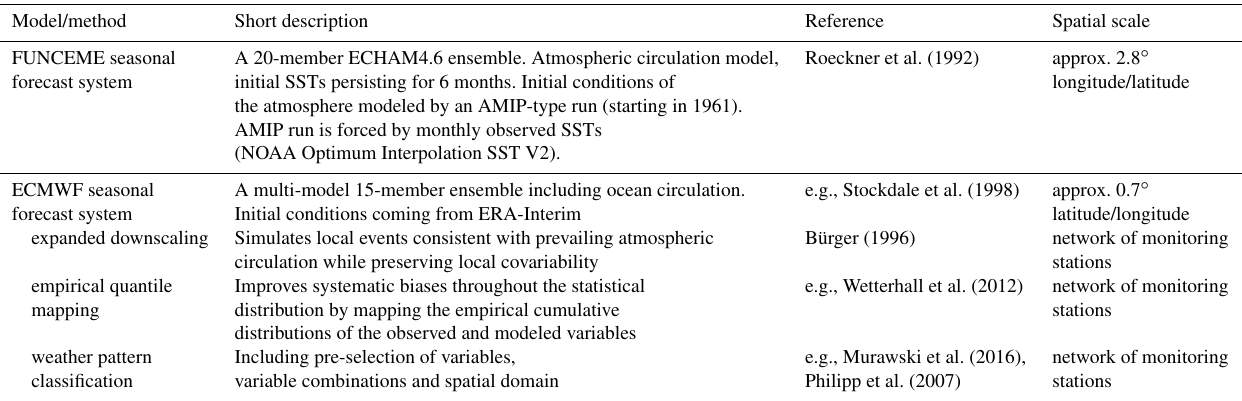
Table 1. Output variables of each prediction model used in this